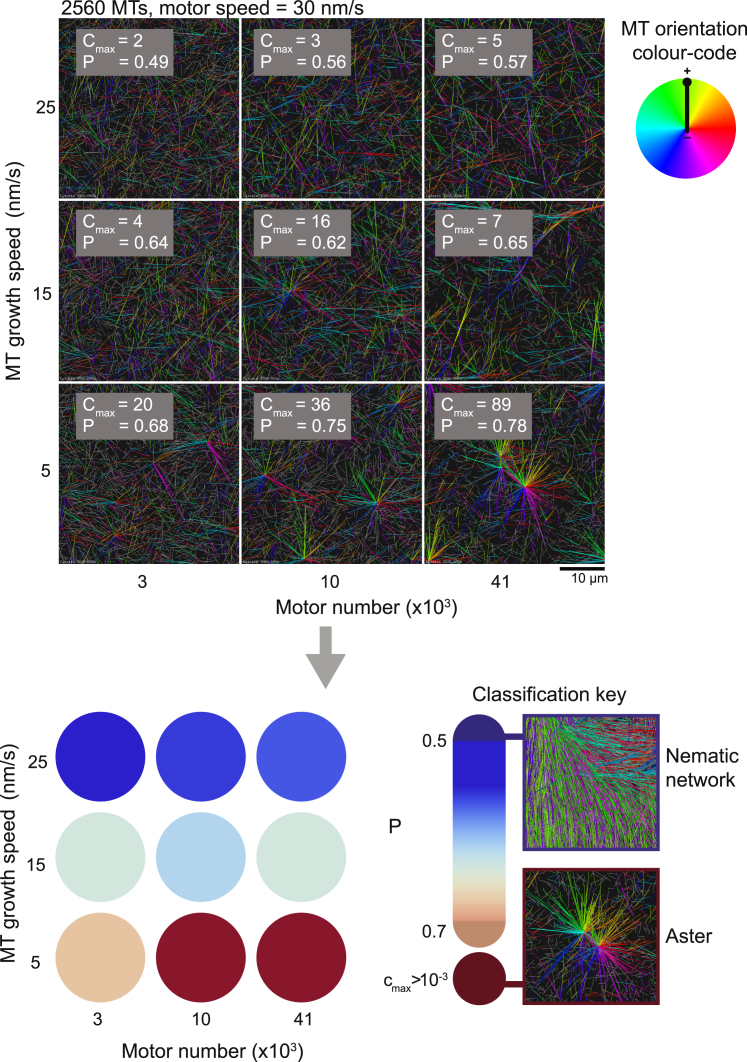
Visualization of the Phase Space of Simulated Microtubule-Motor Networks by Classifying and Color-Coding the Network Types, Related to Figure 5Bespoke order parameters reveal a gradual transition between nematic and polar states. Final snapshots from 9 of the simulations from the phase space in Figure 5A, left, are shown. All simulation images are three-dimensional projections of a snapshot onto the x-y plane. Colors indicate microtubule orientation. Color code: right. For visual clarity unconnected microtubules bearing no crosslinking motors are displayed in gray. Each simulation outcome is classified using two bespoke parameters cmax and P (STAR Methods). The values of Cmax and P are shown overlaid on the snapshots, where Cmax = cmax x microtubule number. The classified state is displayed in the phase space below as a colored circle according to the classification key (left of the phase space). Due to low microtubule numbers in this parameter scan the nematic states (blue circles) show less alignment than the nematic network of aligned microtubule domains described in Figures 4A and 4D. However, the degree of polarity-sorting, captured by P, is similar in both cases.